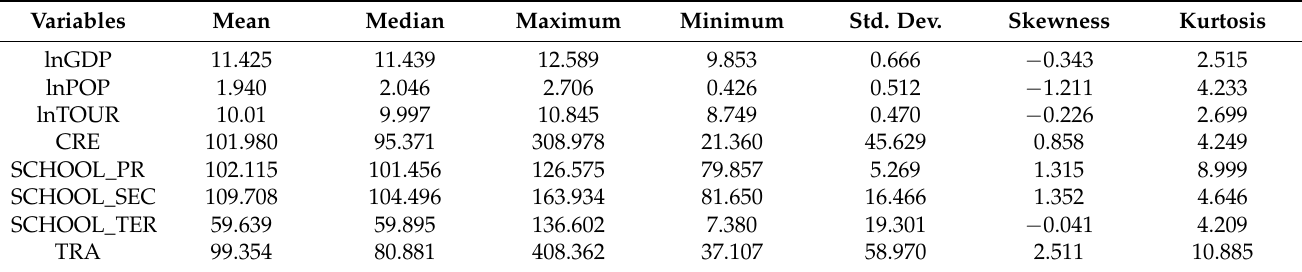
Table 1. Summary